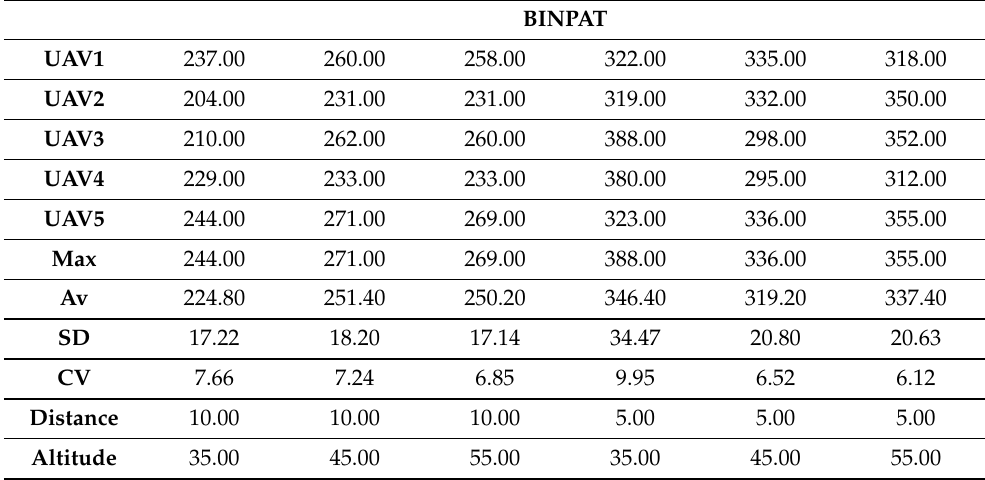
Table A5. Time results using the BINPAT algorithm and five UAVs in a short-track scenario.